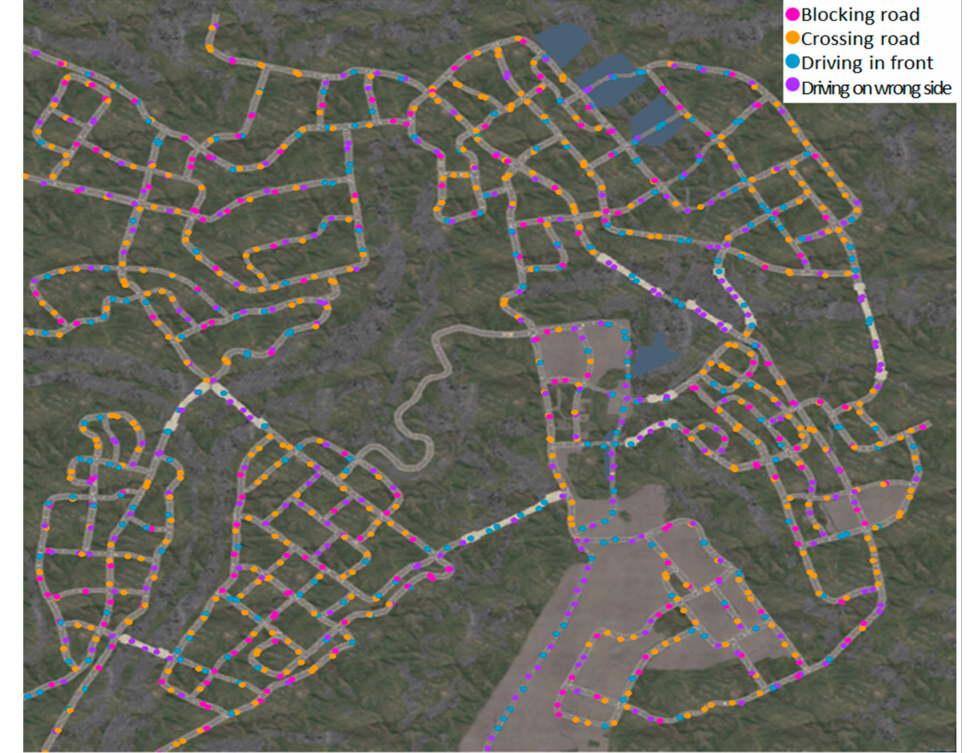
Figure 20. An example of generated scenario map in the automatic event